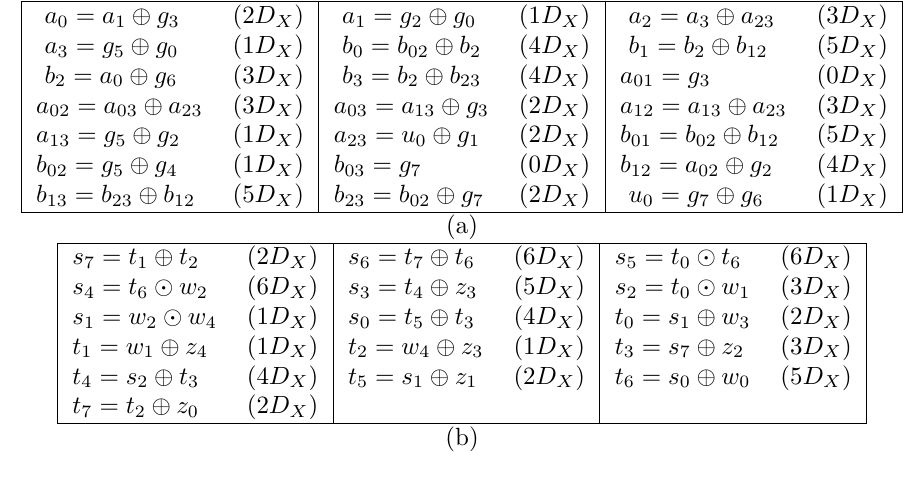
Table 3: Lightweight implementation of transformations in Figure 2: (a) Computation of g 20 = T in × g in (15) for the input transformation. (b) Computation of s = ( T out × f 10 ) ⊕ h in (16) for the output